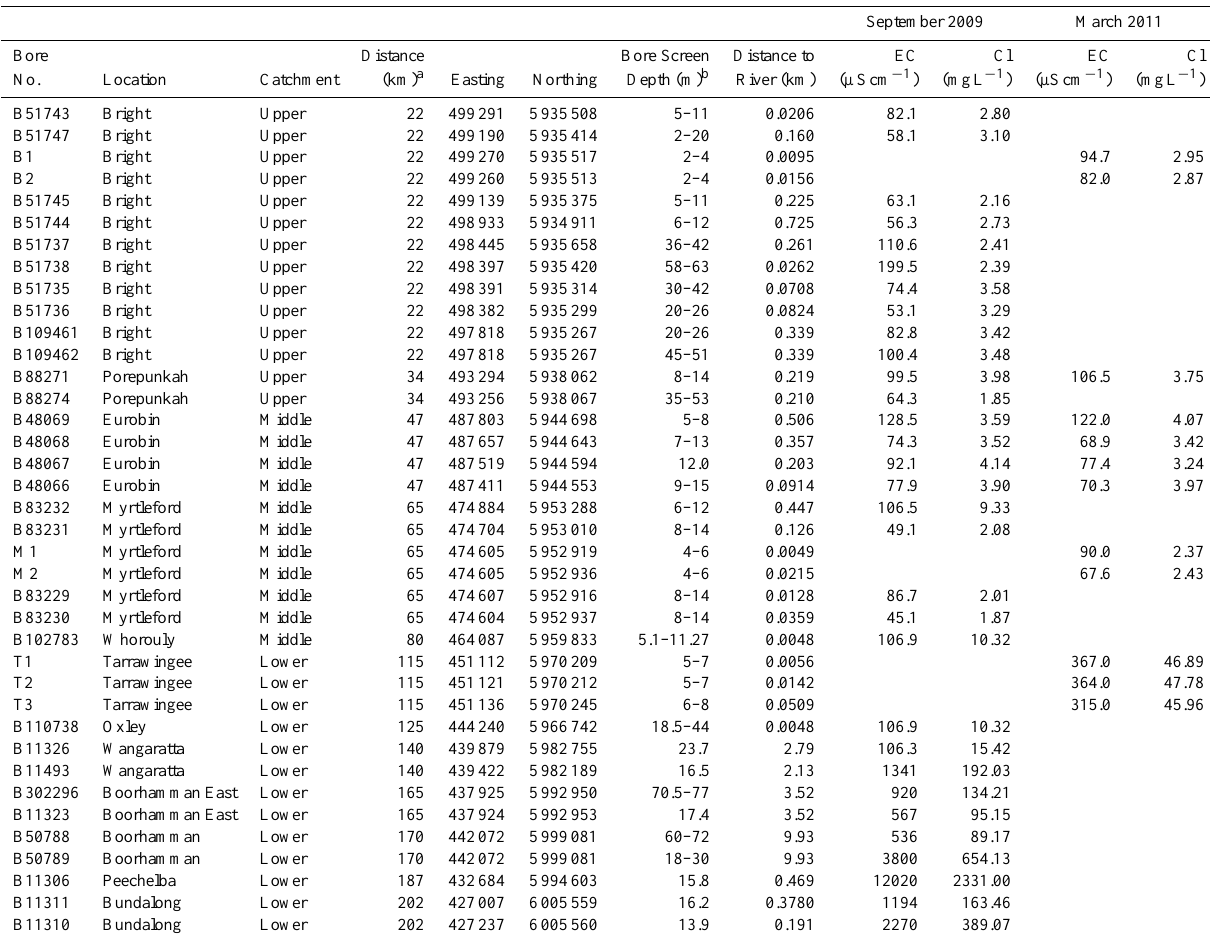
Table 2. EC values and Cl concentrations of groundwater in the Ovens Catchment. Notes – b: if single value is reported, the value represents the depth of the middle of the bore screen below ground